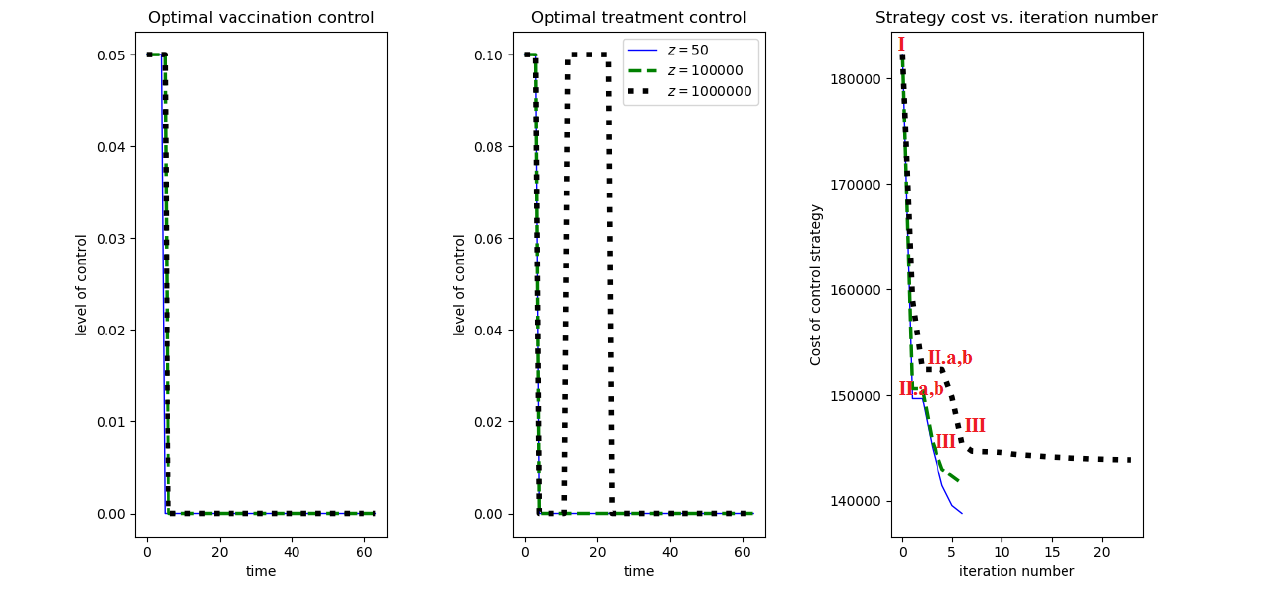
Figure 14. Optimal vaccination, treatment controls and strategy cost for different values of z .